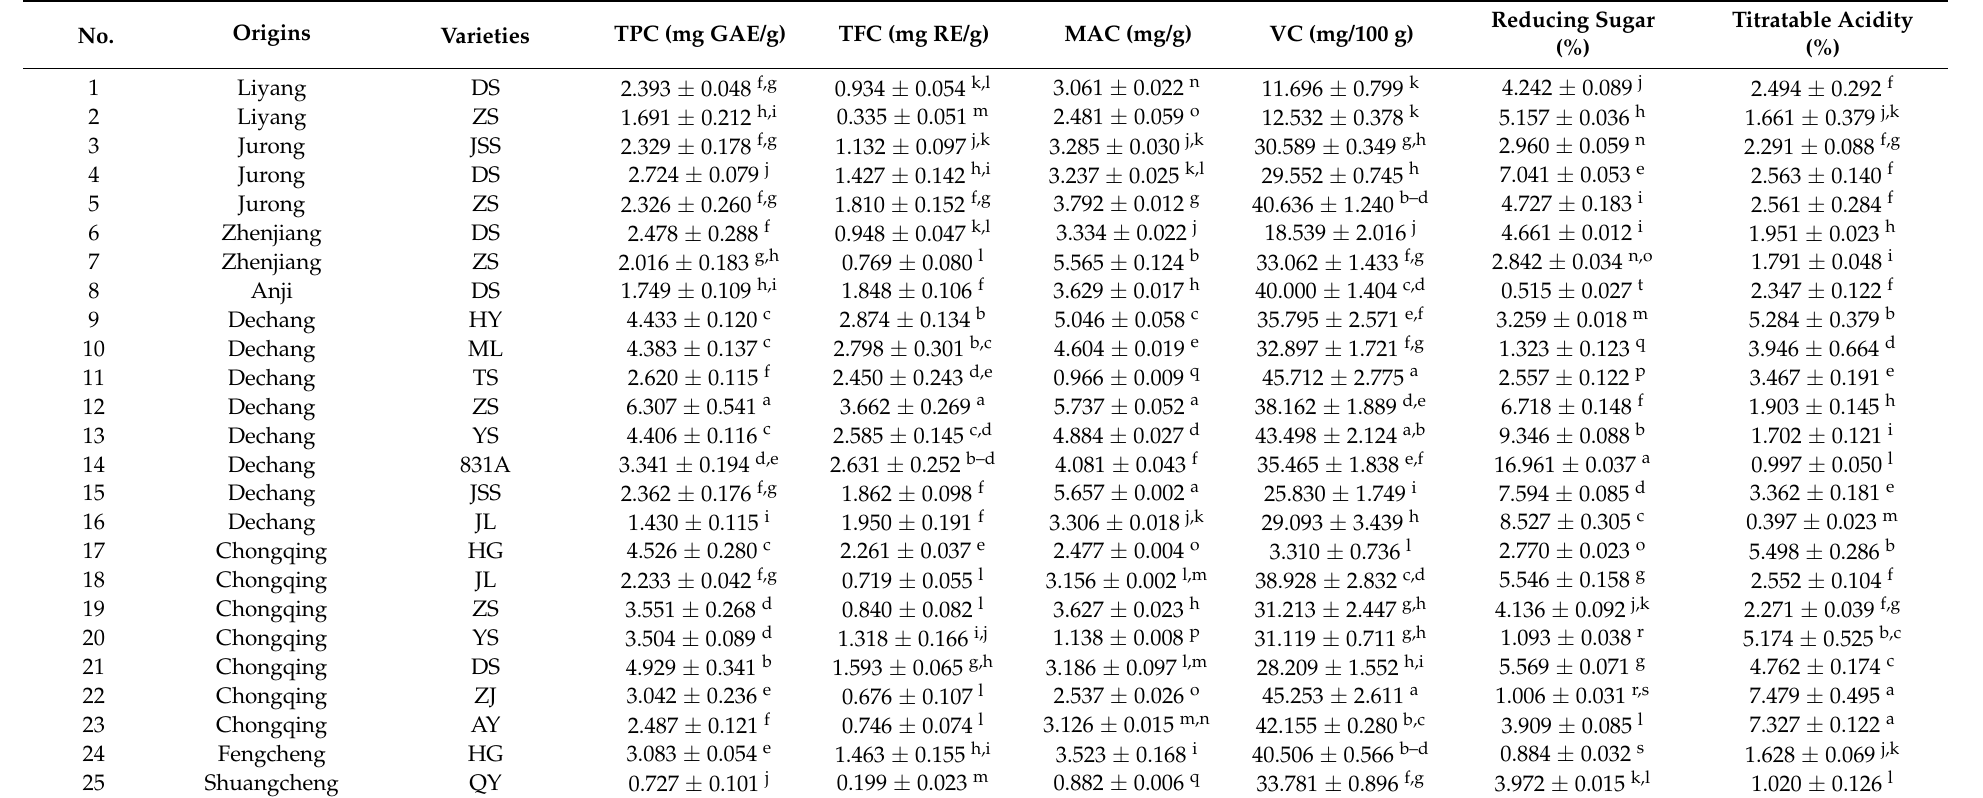
Table 2. The contents of total phenolic, total flavonoid, main anthocyanin, VC, reducing sugar, and titratable acidity of mulberry fruits among varieties from different areas in